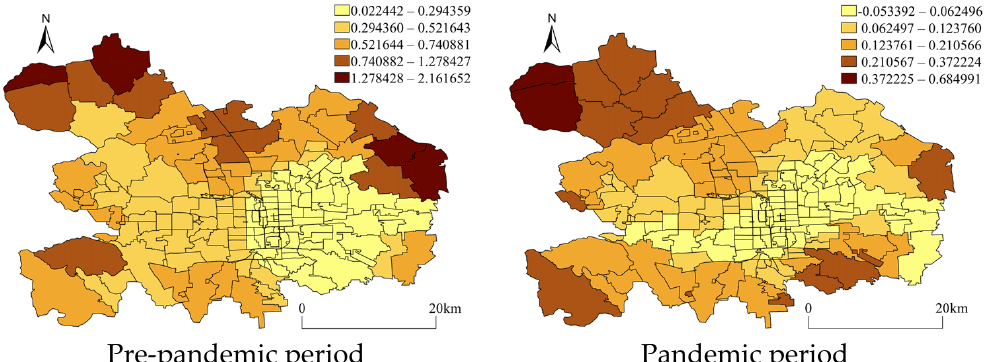
Figure 6. Coefficients of road density for pedestrians from GWR with residential burglary. The coefficients were categorized by using natural breaks.